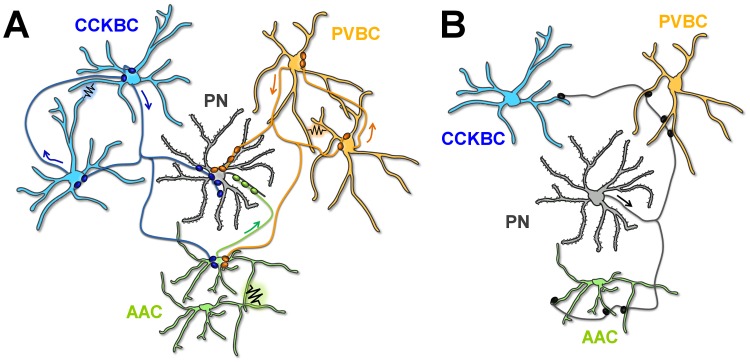
The wiring diagram of the 3 perisomatic region-targeting interneurons and principal neurons (PNs) in the basal amygdala (BA).(A) Connectivity among the distinct interneuron types and from interneurons to the PNs. Both synaptic connections and gap junctions are indicated. Arrows show the direction of action potential spread along the axons. (B) Connectivity from the PNs to interneurons.